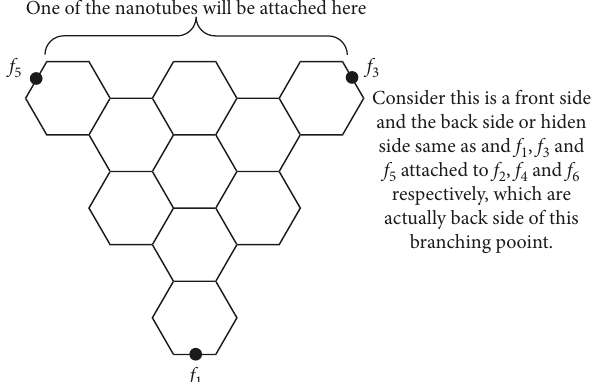
Figure 1: A branching point Y